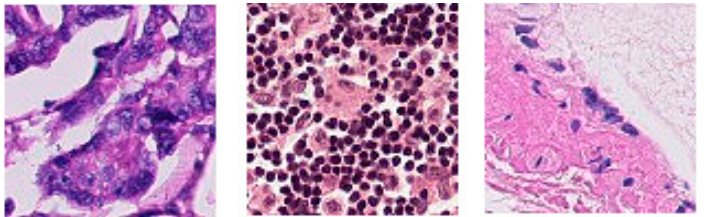
Figure 1. Example of images available in the PatchCamelyon dataset [20].